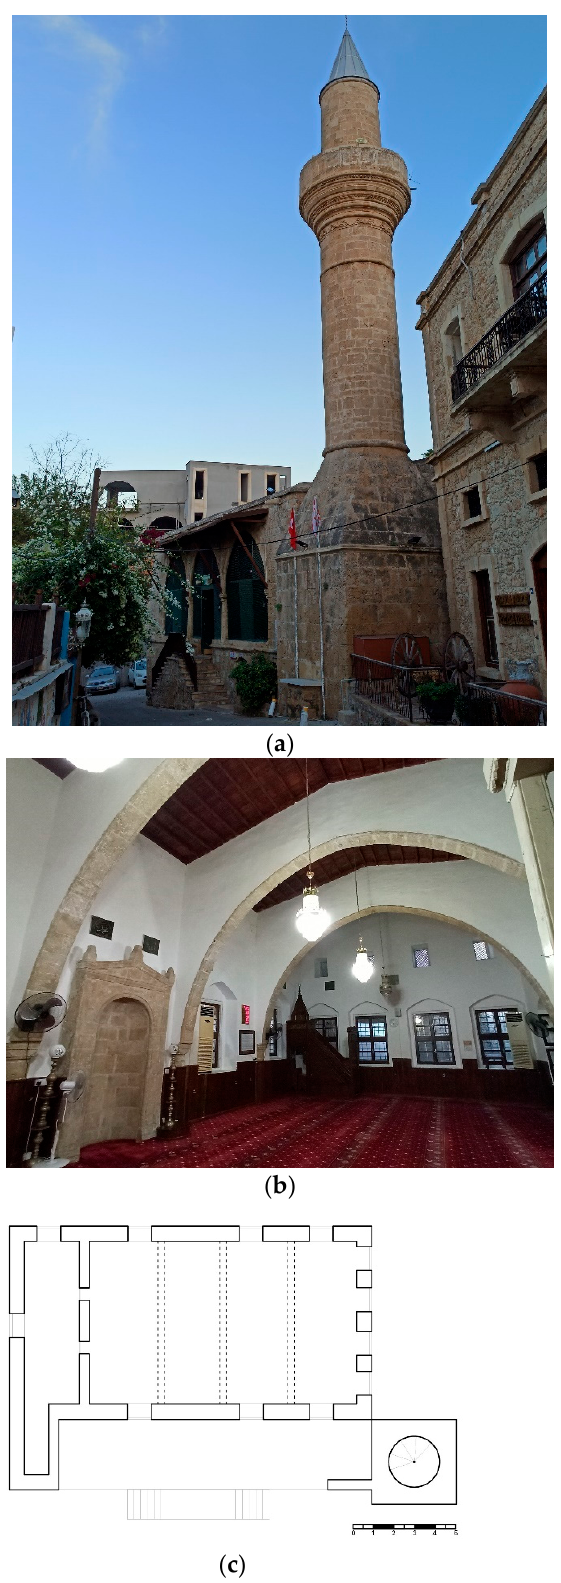
Figure 3. Kyrenia, A ğ a Cafer Pa ş a mosque, late 16th century and 1878–80 (vernacular type): ( a ) en- trance façade with arcaded portico; ( b ) interior with view onto mihrab and quibla on the left; ( c ) plan, based on Ba ğ i ş kan (2009, p. 196, plan 40) (photos: authors; drawing: authors and Mojtaba Ka- rimnezhad).